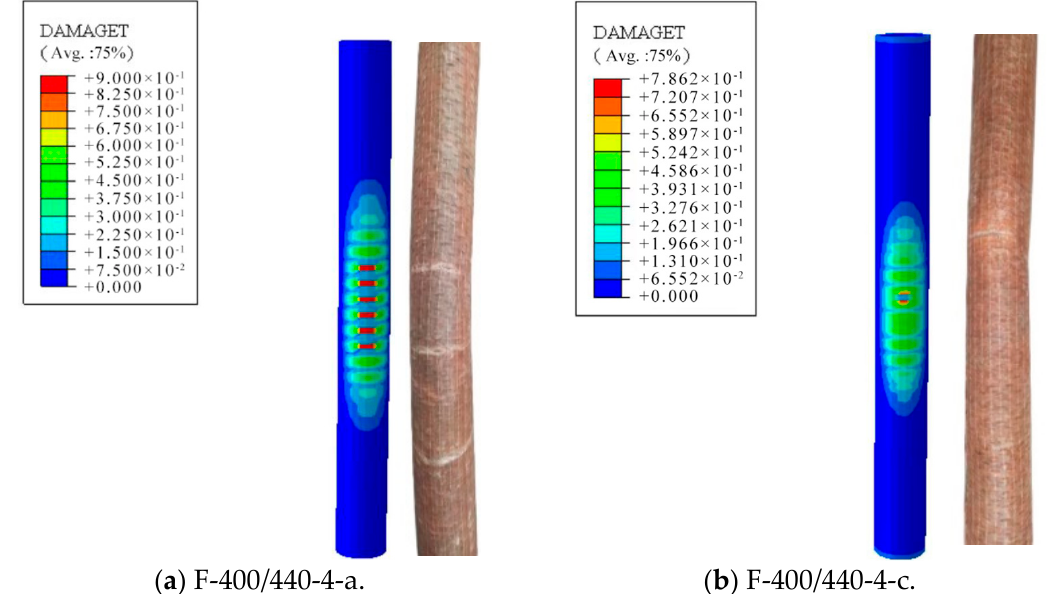
Figure 8. Comparison between simulated and experimental failure modes of FCCC-R specimens.